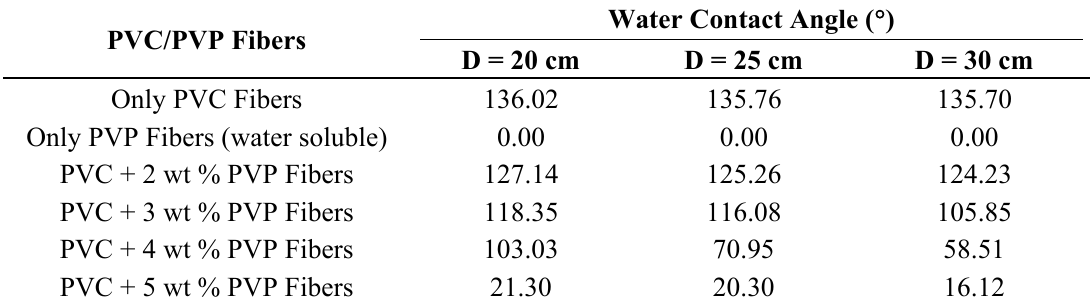
Table 1. Contact angle values of polyvinyl chloride (PVC) membranes incorporated with different weight percentages of polyvinylpyrrolidone (PVP) at three spinneret